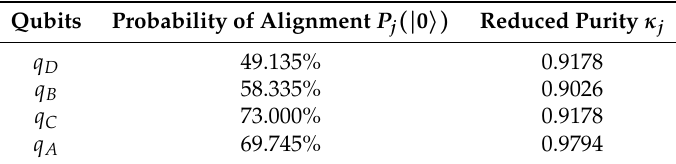
Table 1. Summary of the results.